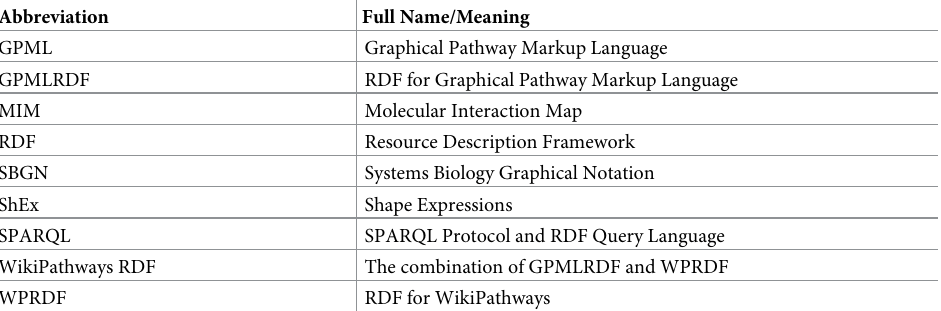
Table 1. Abbreviations for semantic web technologies used to harmonize the biological interaction information from